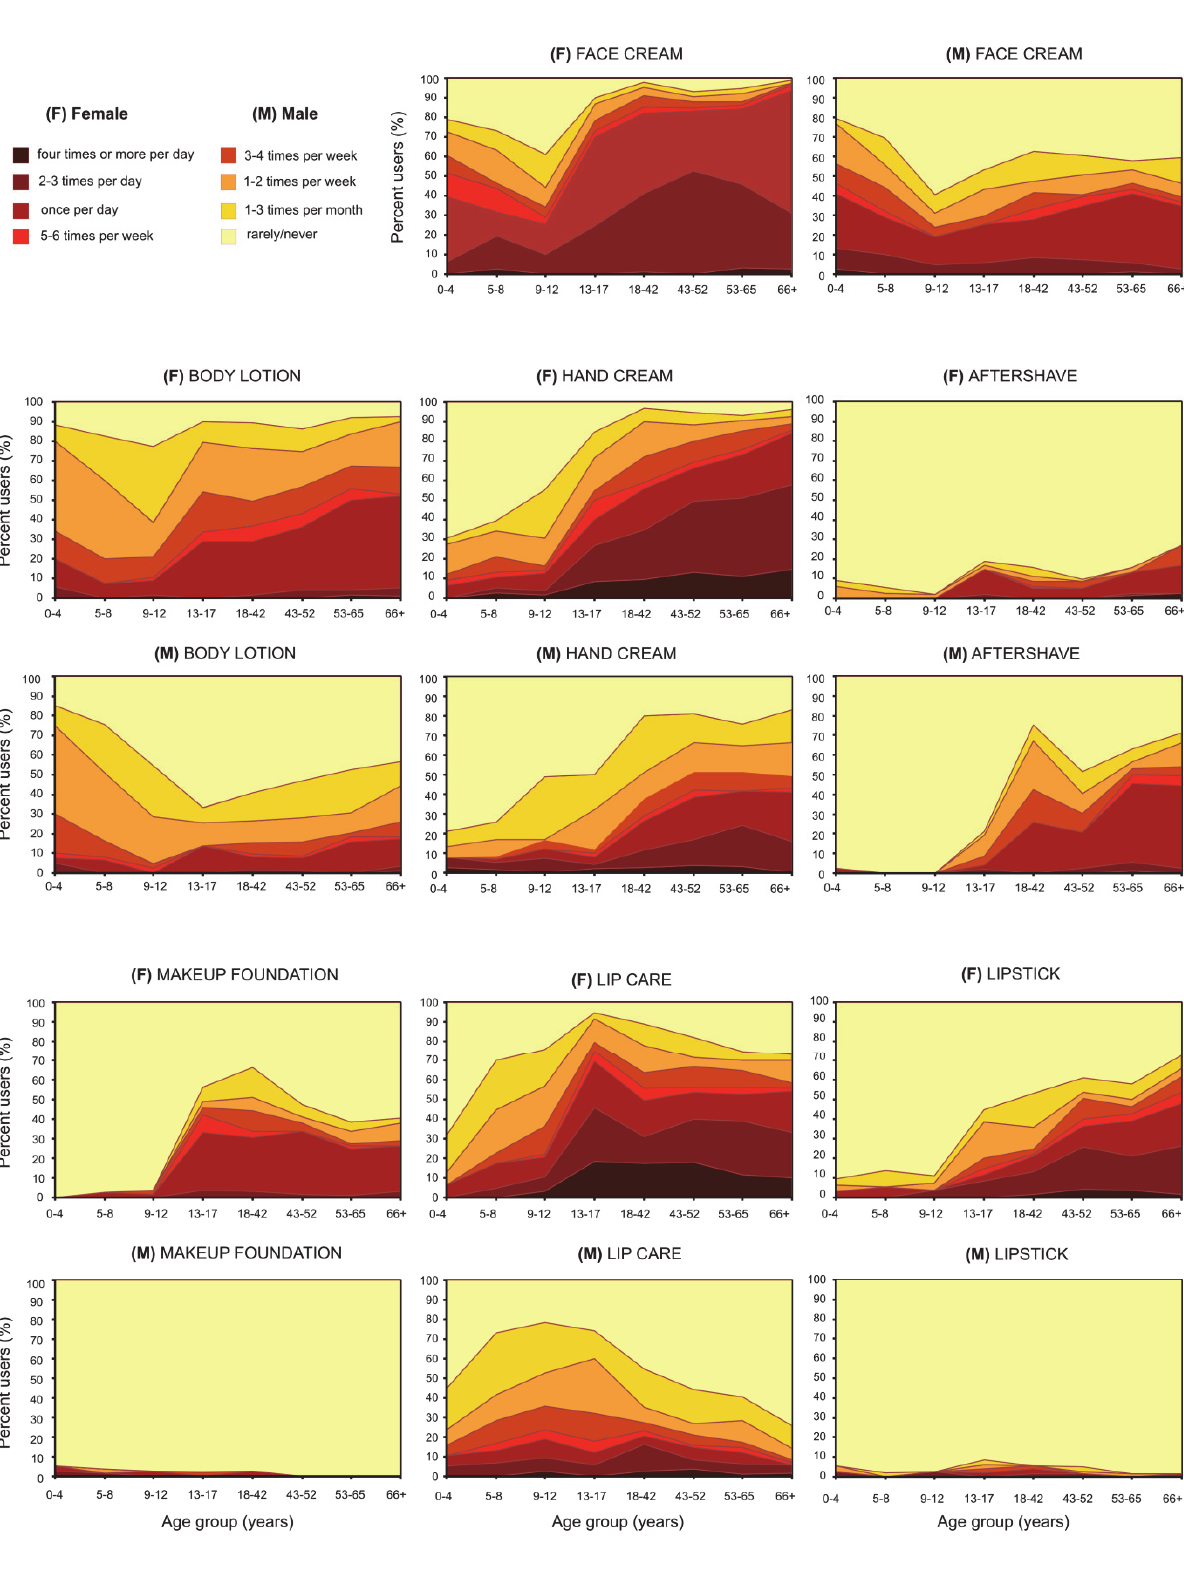
Figure 2. Distributions of use prevalence and frequency of routinely used PCPs across age and by